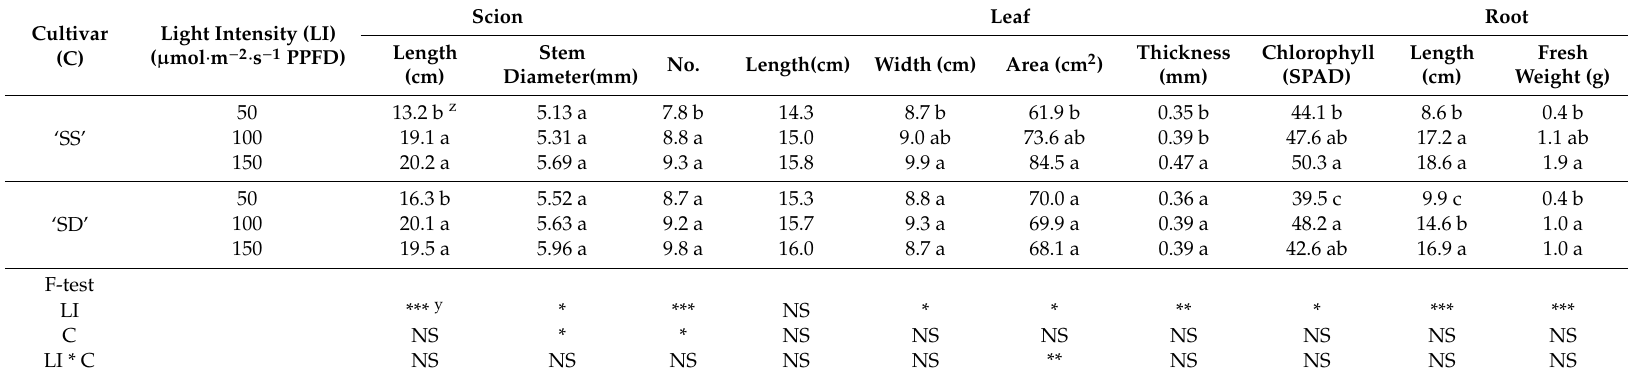
Table 1. Influence of supplemental light intensity on growth and development of grafted tomato seedlings grown for 10 d. Cultivar